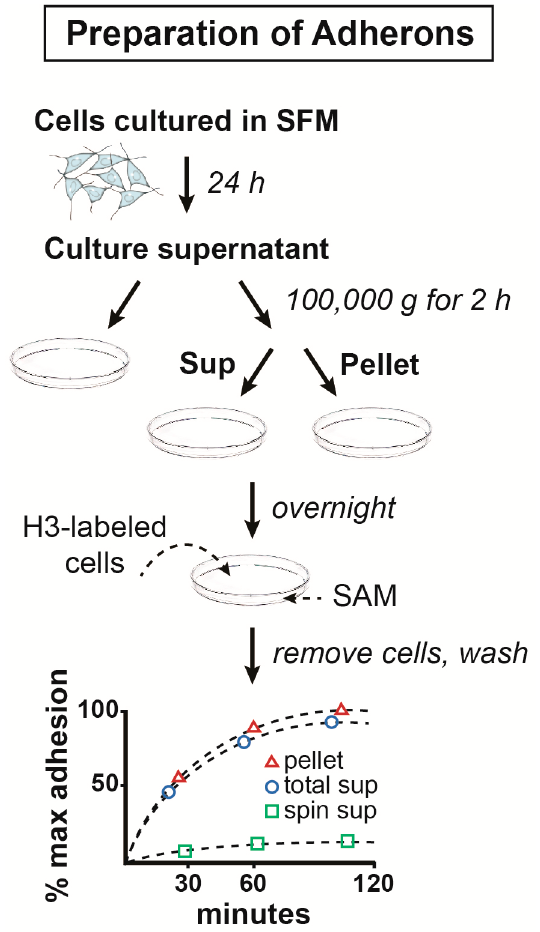
Figure 1. Approach for the preparation of adherons and analysis of their role in cell–substratum adhesion.